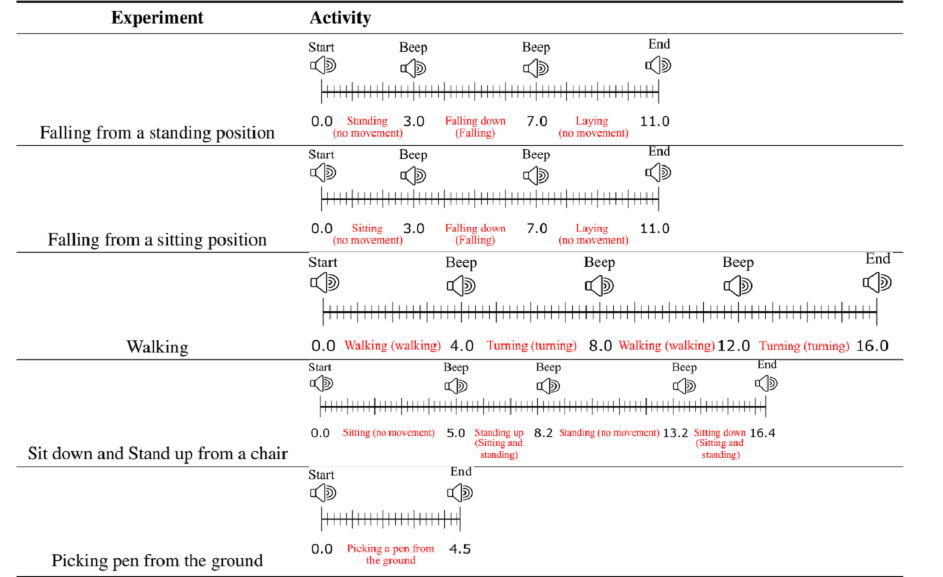
Figure 6. The timing diagrams of the identified